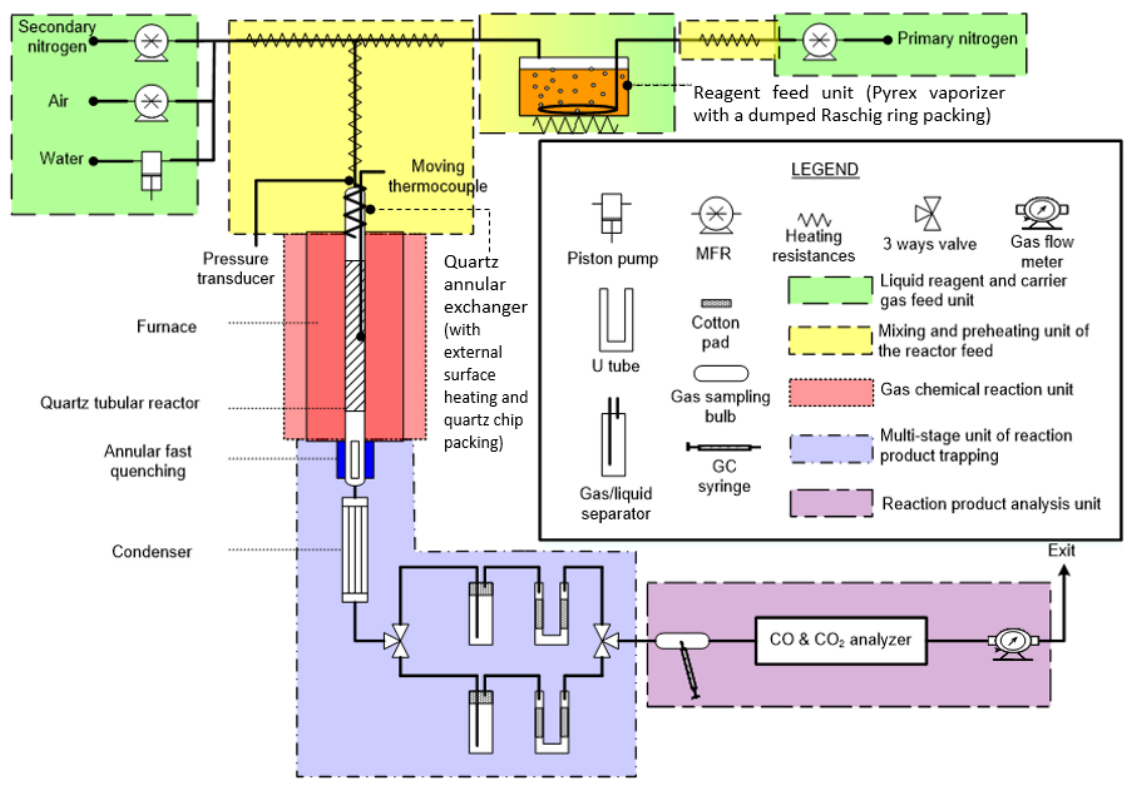
Figure 1. Schematic overview of the designed bench-scale experimental setup.